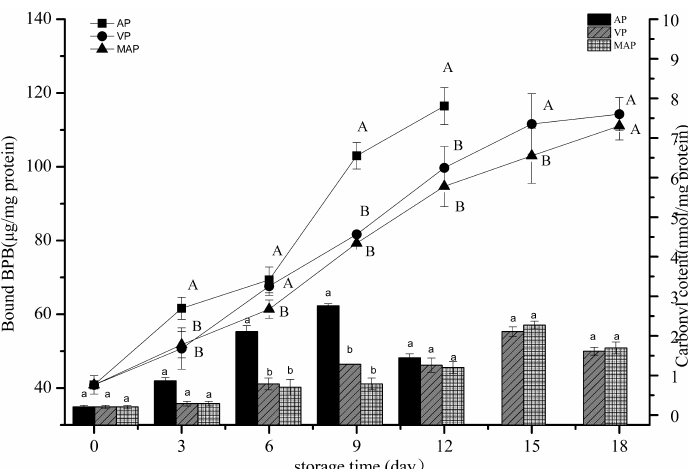
Figure 2. Changes in carbonyl content (bar graph) and protein surface hydrophobicity (expressed as Bound BPB, line graph) of grouper myofibrillar protein. (AP: air packaging; VP: vacuum packaging; MAP: modified atmosphere packaging; BPB: bromophenol blue).